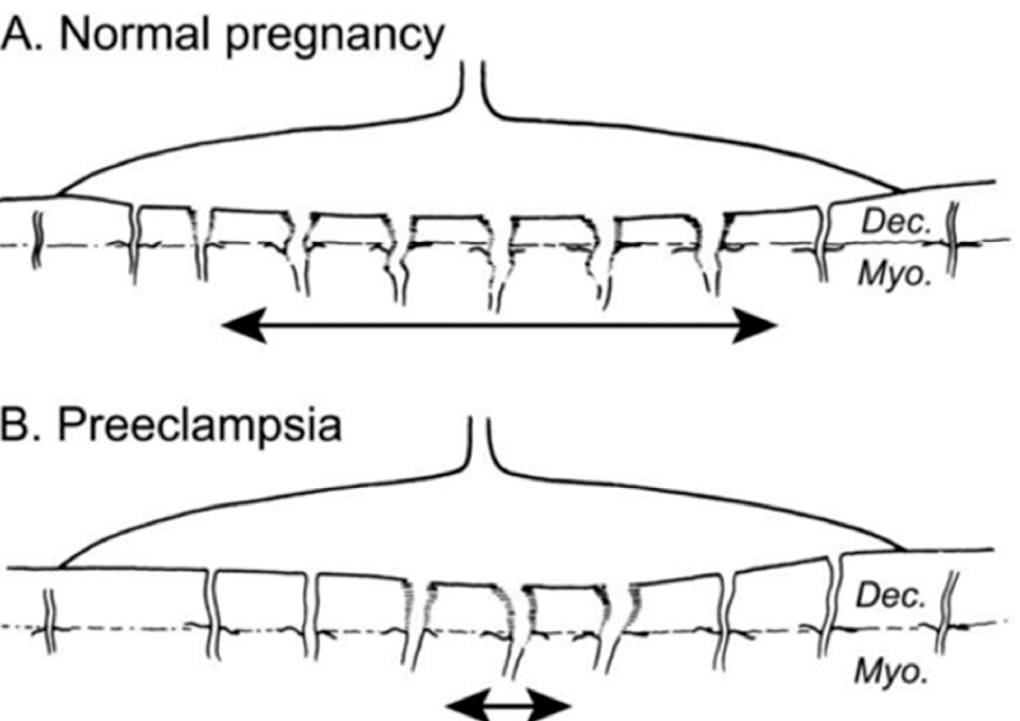
Figure 4. ( A ) Normal placental bed with full transformation of the myometrial spiral arteries with widened vascular diameters except at the periphery of the placental bed. ( B ) Defective deep placentation is characterized by non-transformation of the myometrial spiral arteries, reducing placental blood flow within the central area with a paucity of deep placentation [42].